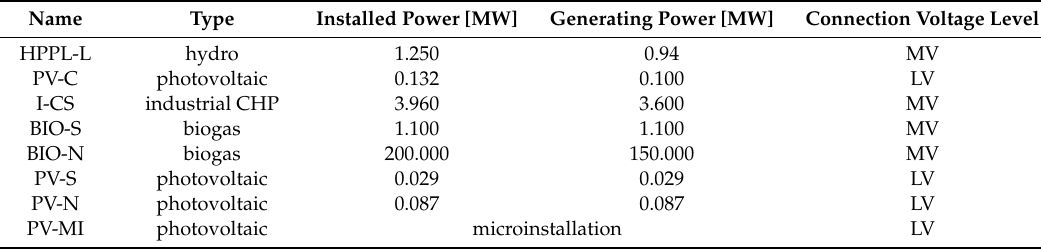
Table 3. Energy storage system (ESS) integrated with the